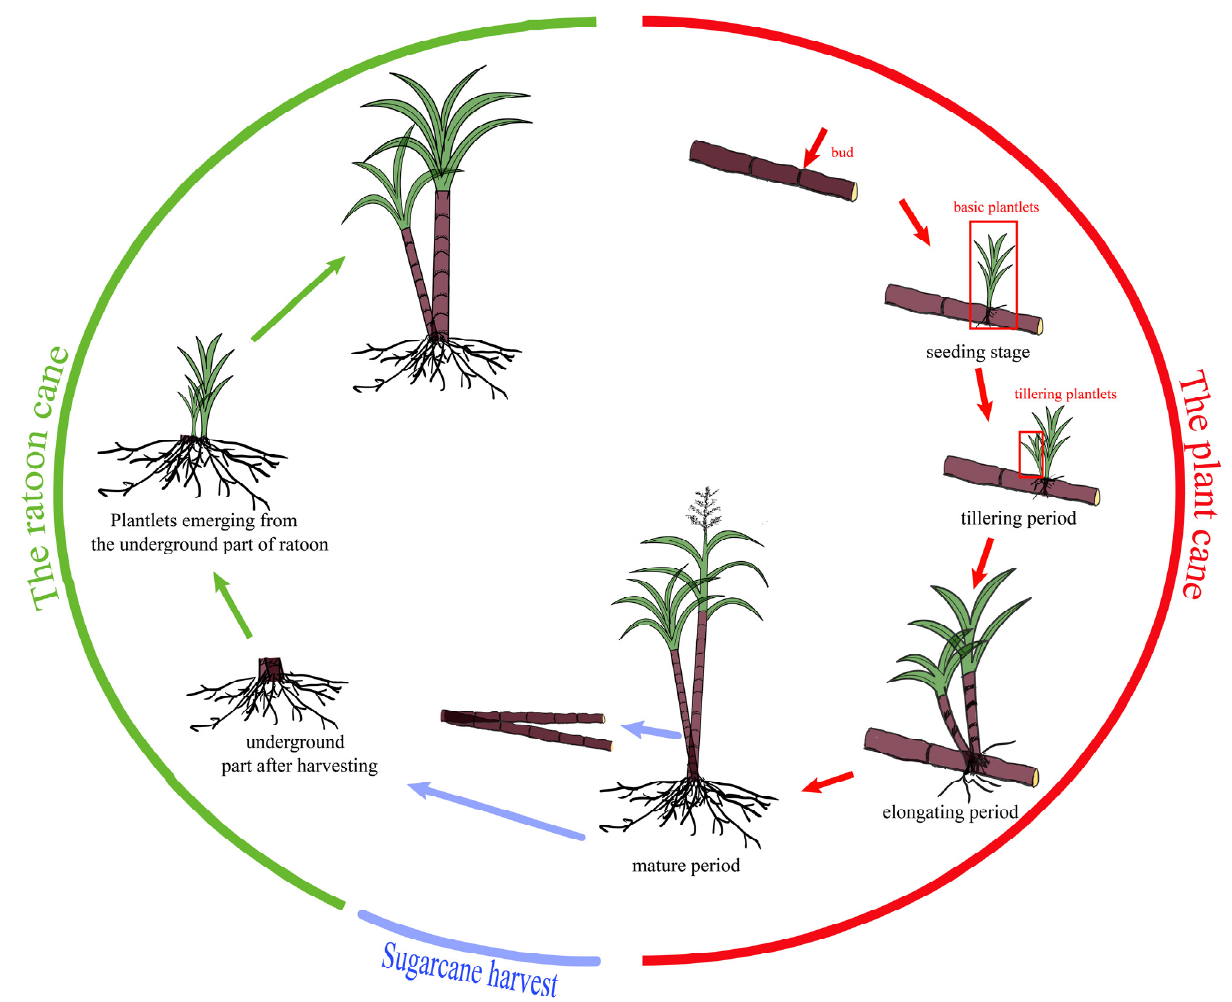
Figure 1. Diagram of sugarcane growth cycle pattern.